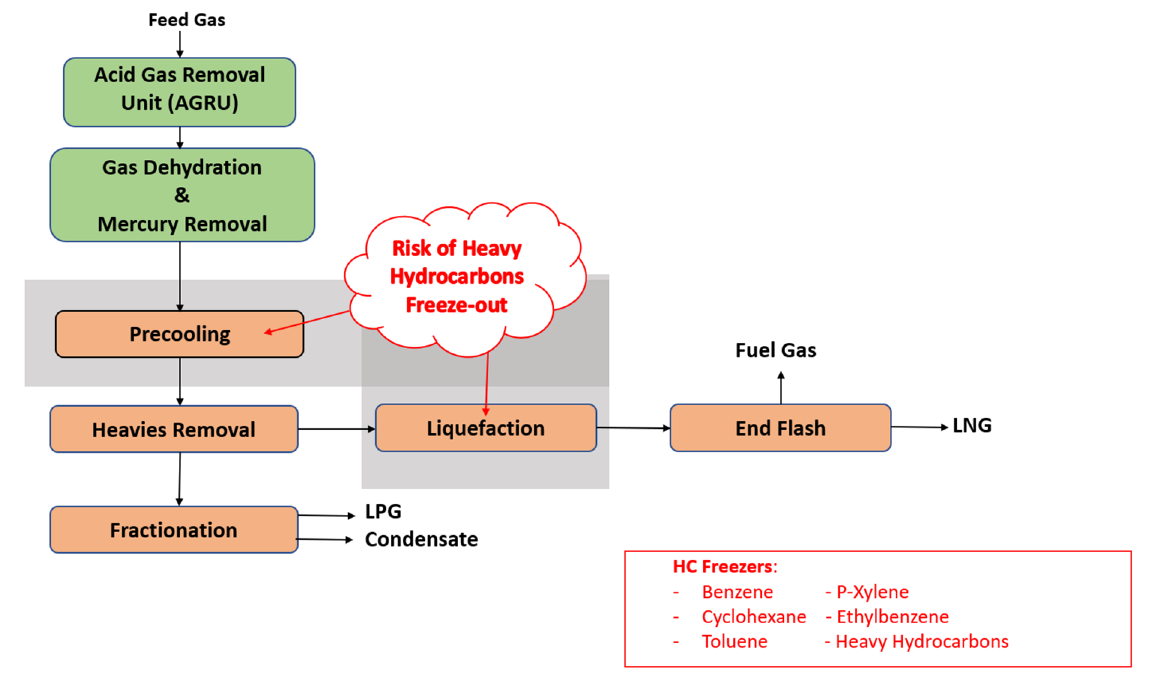
Figure 2. Potential locations of HHC freeze-out in an LNG plant.